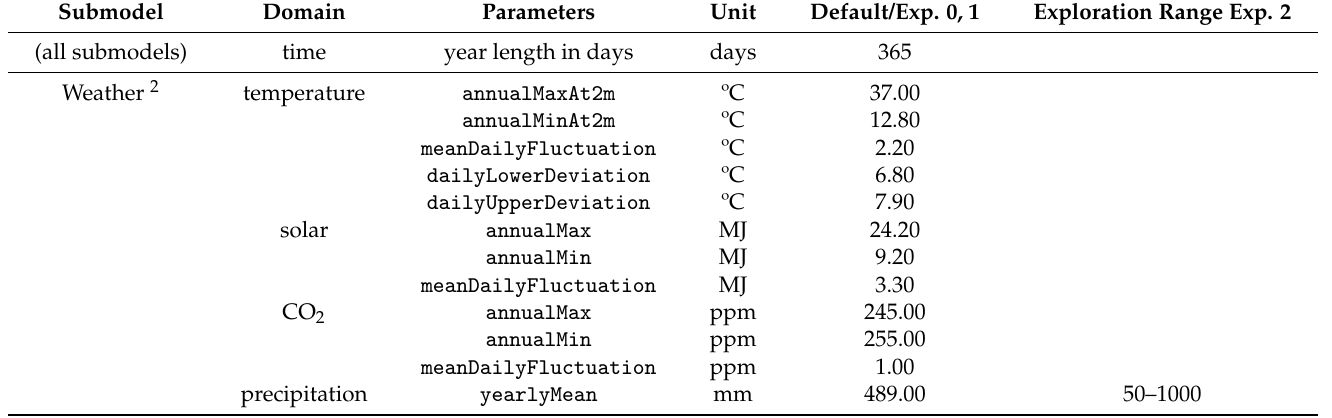
Table 3. Weather, soil water, and crop models parameters’ values used in experiments 0 1 , 1, and